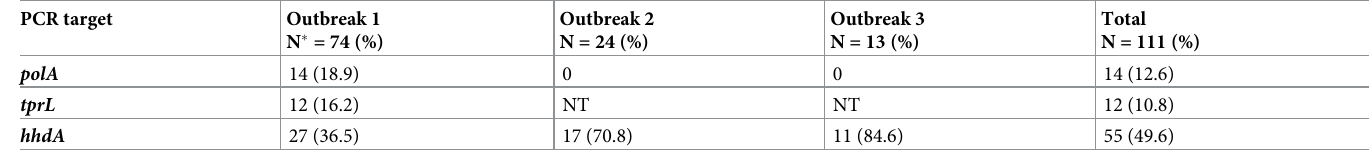
Table 4. Presence of T . pallidum , T . pallidum pertenue and H . ducreyi DNA in samples collected in the context of the three